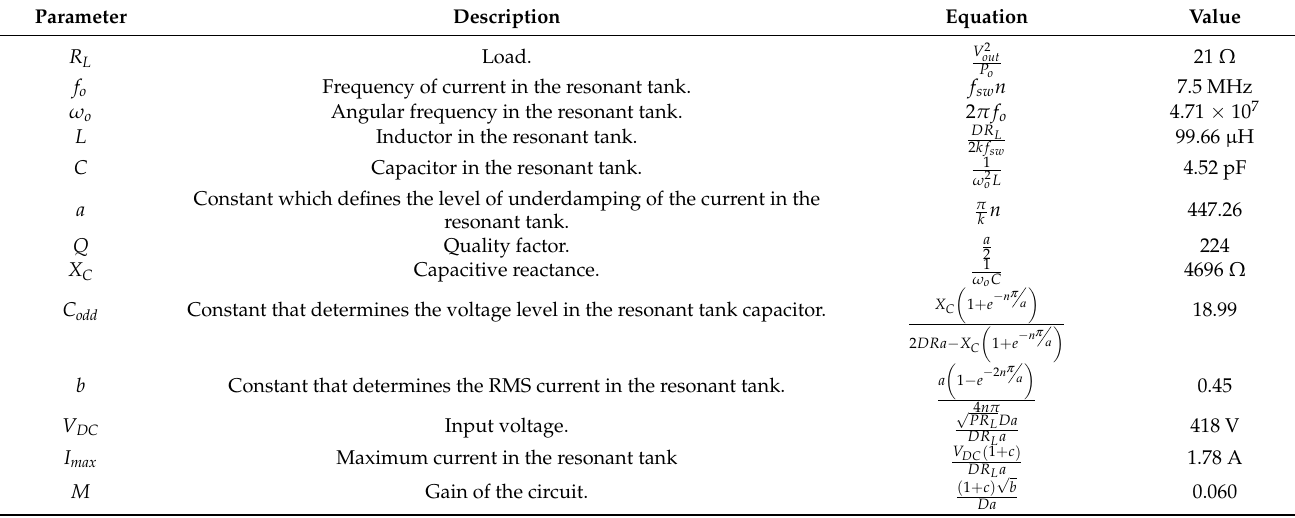
Table 2. Design methodology.